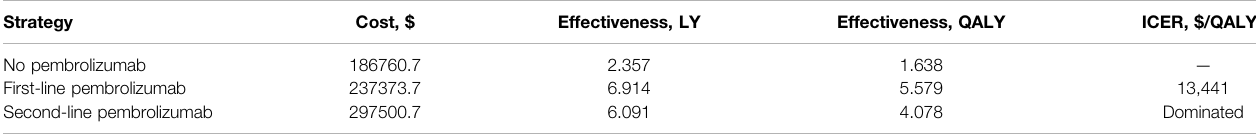
TABLE 3 | Base-case results.